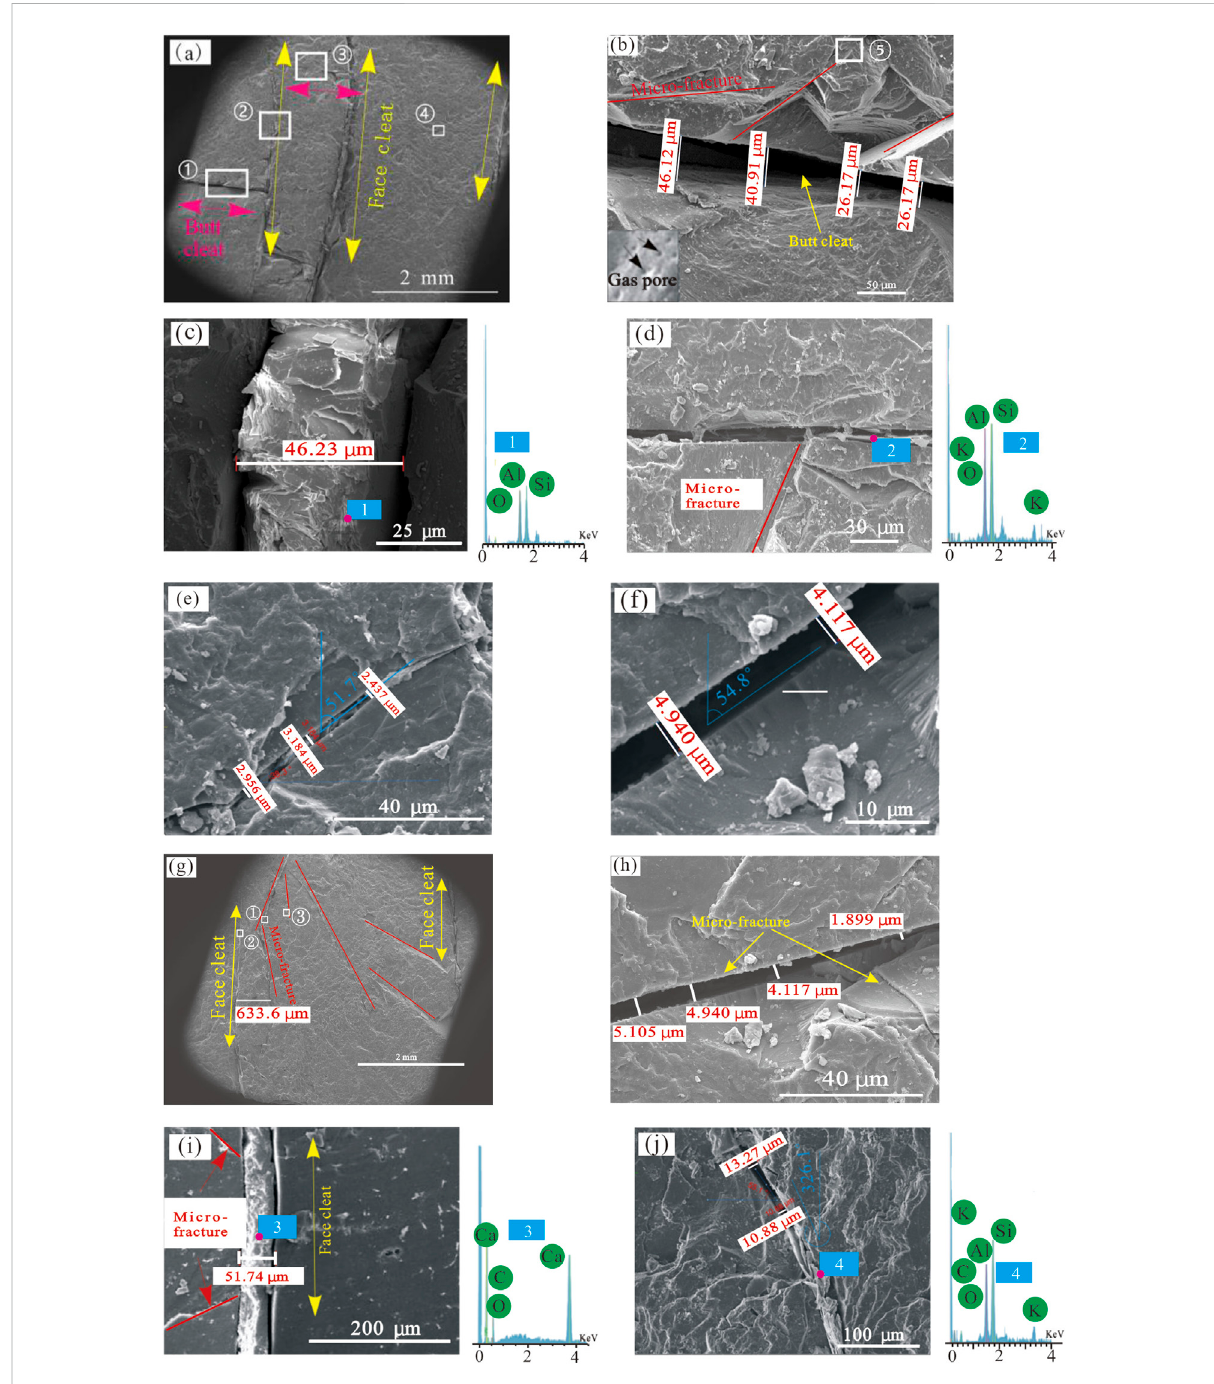
FIGURE 6 Cleat and micro-fractures in the coal: (a) , face cleat and butt cleat; (b) , enlarged view of point 1 in Figure 6(a); (c) , enlarged view of point 2 in Figure 6(a); (d) , enlarged view of point 3 in Figure 6(a); (e) , enlarged view of point 4 in Figure 6(a); (f) , enlarged view of point 5 in Figure 6(b); (g) , face cleat and micro-fracture; (h) , enlarged view of point 1 in Figure 6(g); (i) , enlarged view of point 2 in Figure 6(g); (j) enlarged view of point 3 in Figure